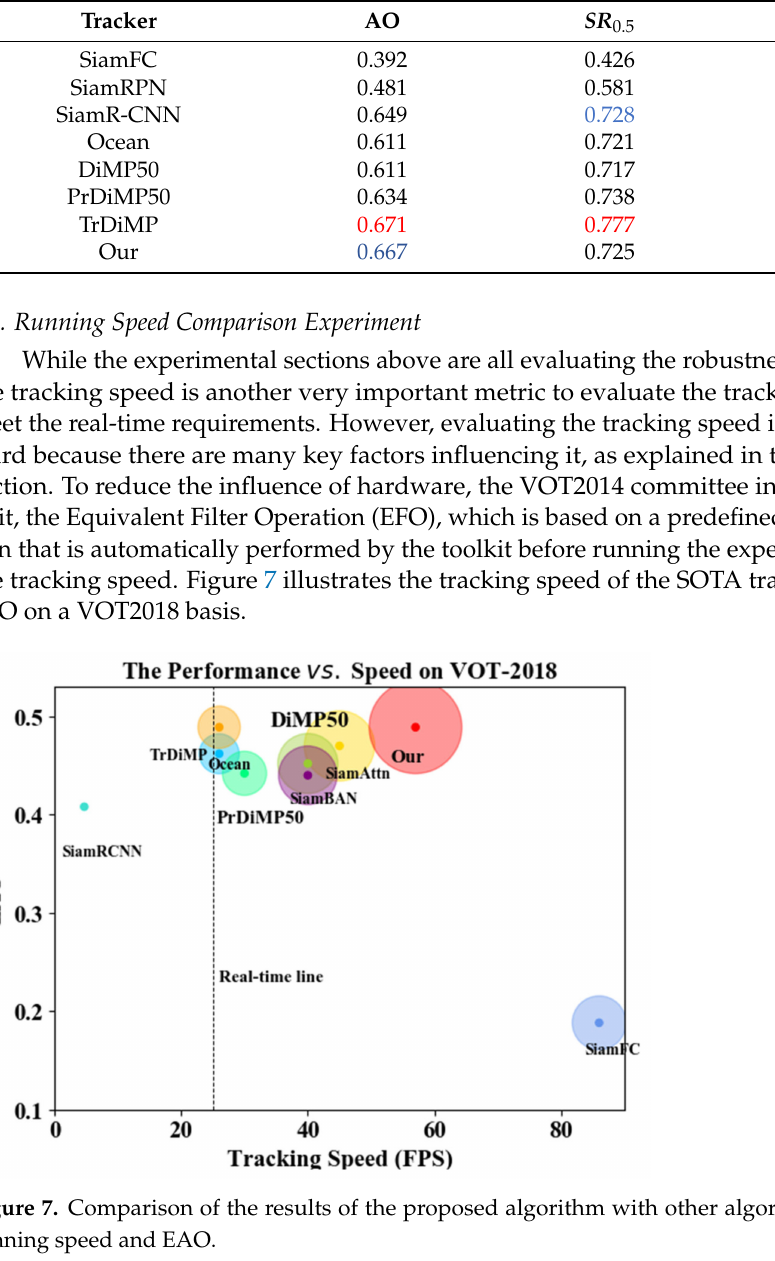
Table 2. AO score ranking of trackers tested at GOT-10k.